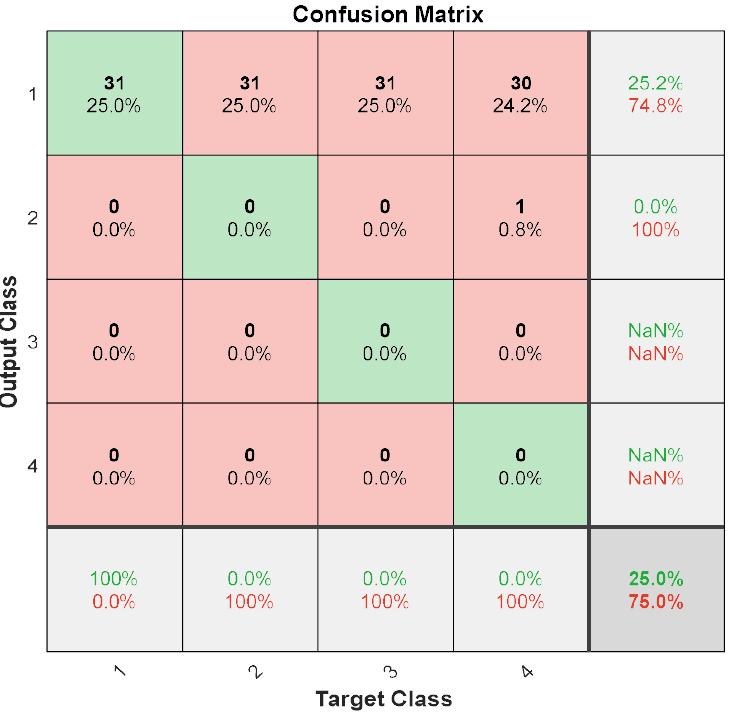
Figure 9. A confusion matrix for noisy LFM by DNN.